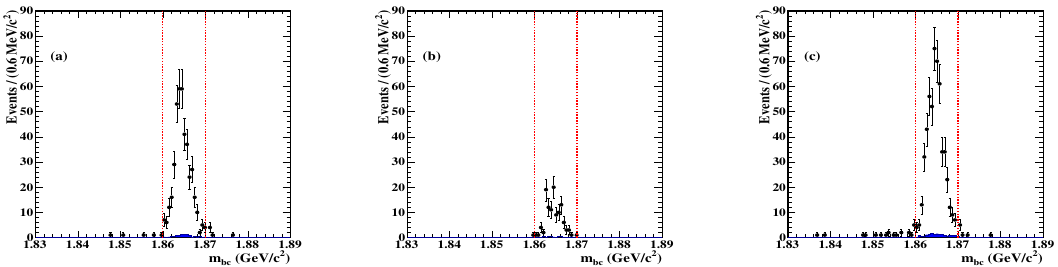
Figure 2 . m bc distributions for D ! K 0 (cid:25) + (cid:25) (cid:0) (cid:25) 0 decays tagged by (a) CP -even states, (b) CP -odd S states both not involving a K 0 meson and (c) K 0 (cid:25) + (cid:25) (cid:0) . The shaded histogram shows the estimated L S peaking background and the vertical dotted lines indicate the signal region.